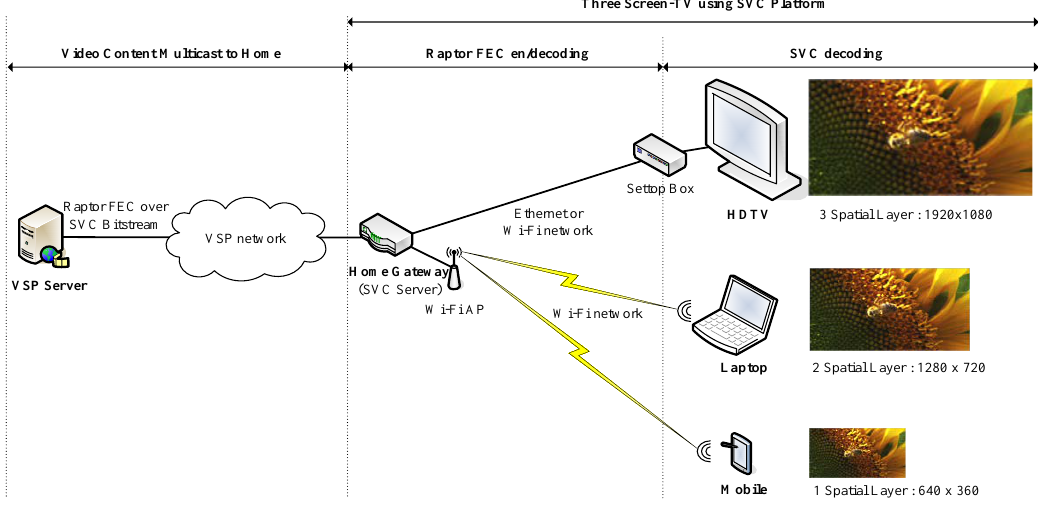
Figure 1. Conceptual diagram of three-screen TV using scalable video. VSP, video service provider; FEC, forward error correction; SVC, scalable video coding.